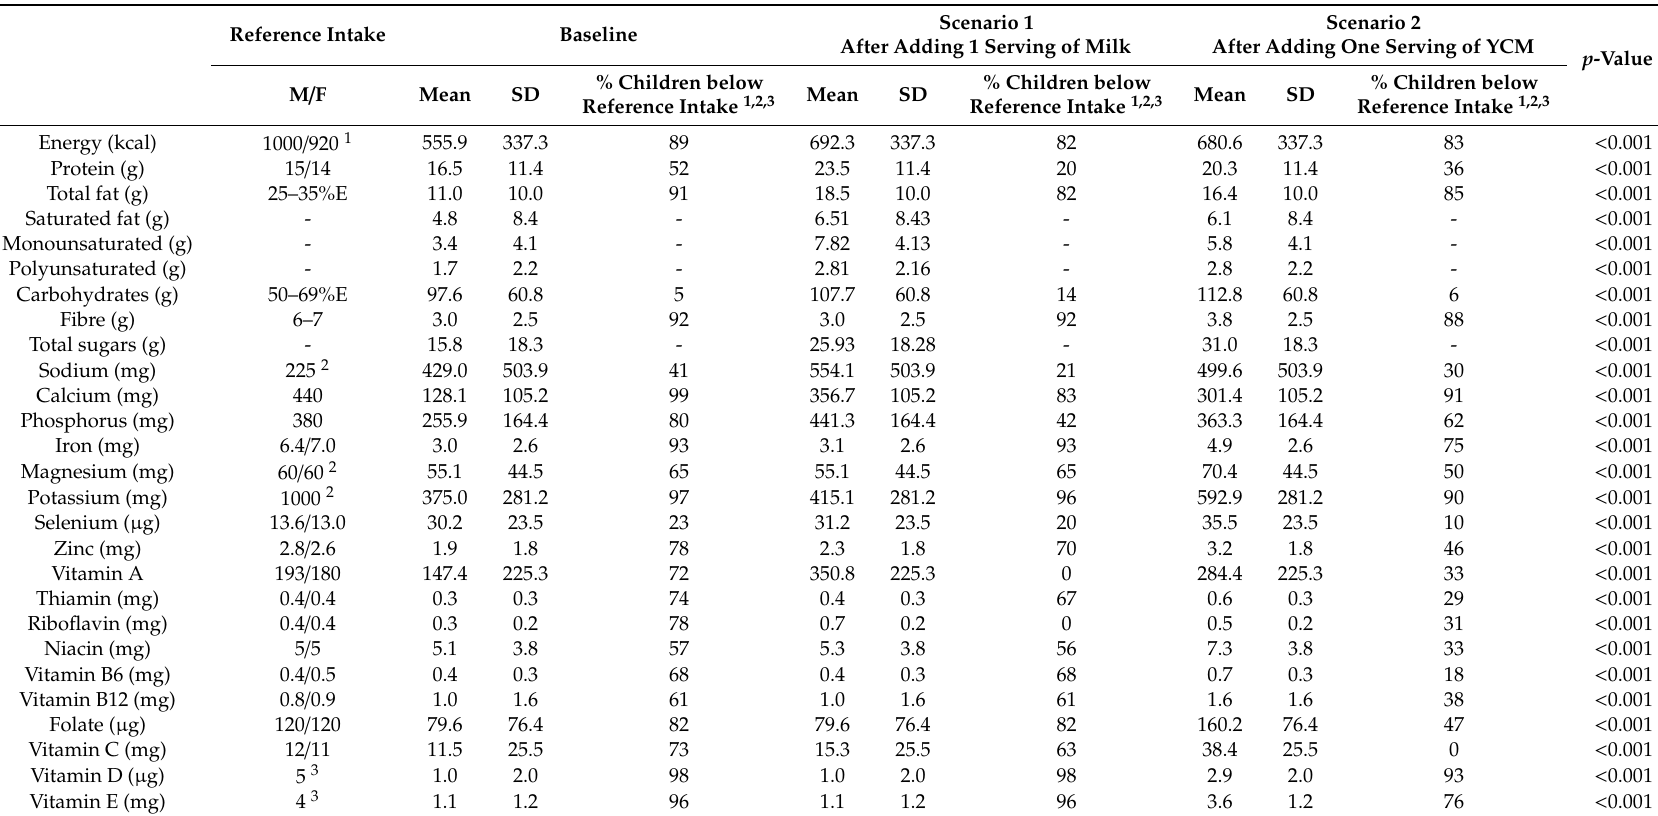
Table 2. Mean nutrient intakes and inadequacy at baseline and after modelling scenarios 1 and 2, in children aged one to two years ( n =